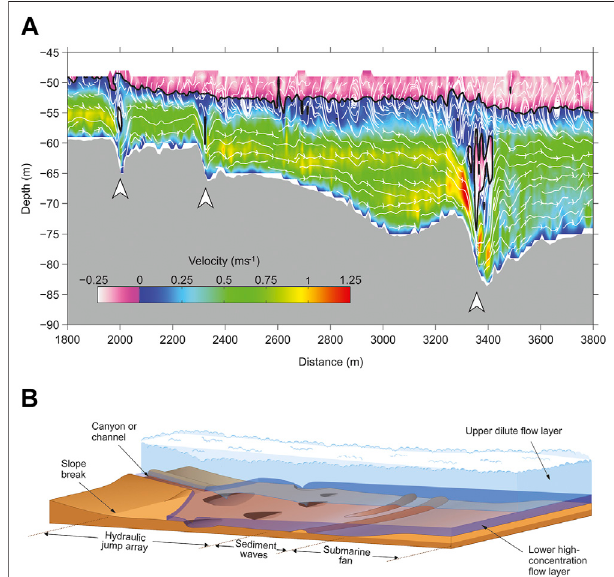
FIGURE 6 | (A) Downstream fl ow velocity distributions over a series of scours and their associated subaqueous hydraulic jumps, in a channelized saline-driven fl ow in the Black Sea. The positions of the hydraulic jumps are marked by white arrows. (B) Schematic channel-lobe transition zone showing an array of subaqueous hydraulic jumps occurring in the lowermost high momentum part of the fl ow. The position and proportion of active hydraulic jumps likely varies between and during fl ows. Modi fi ed from Dorrell et al.